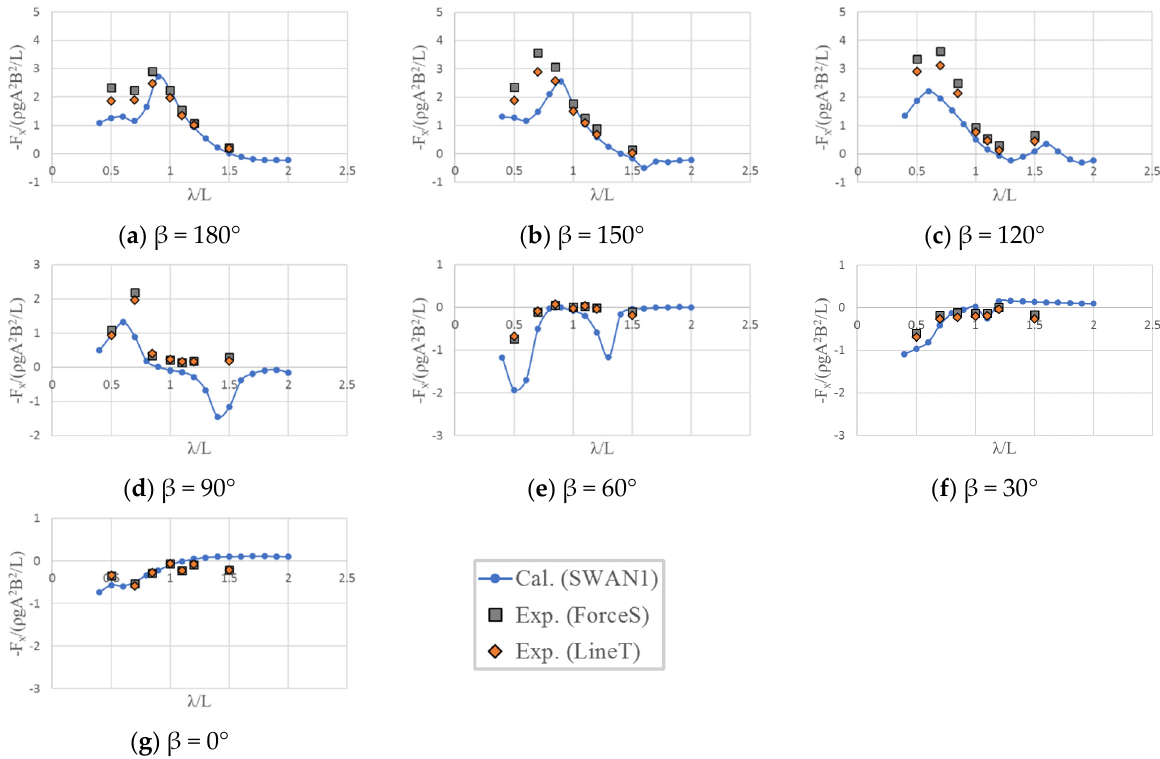
Figure 11. Surge drift force on KVLCC2: V = 6 knots, H/L = 1/50.